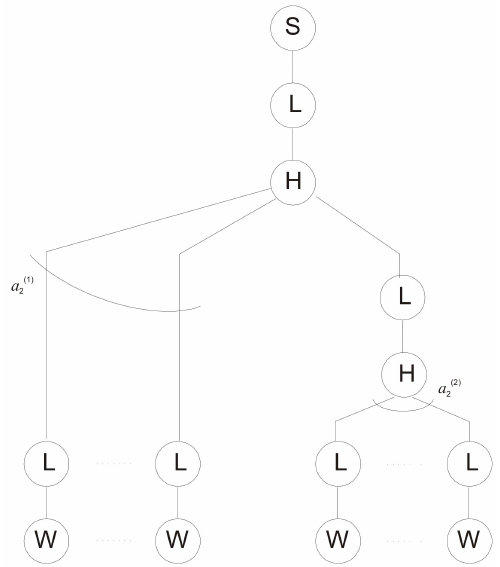
Figure 2. A hierarchical ramified system corresponding to the technical equipment of the local area computer system (where S denotes a server, H -a hub, W -a workstation, L -a communication